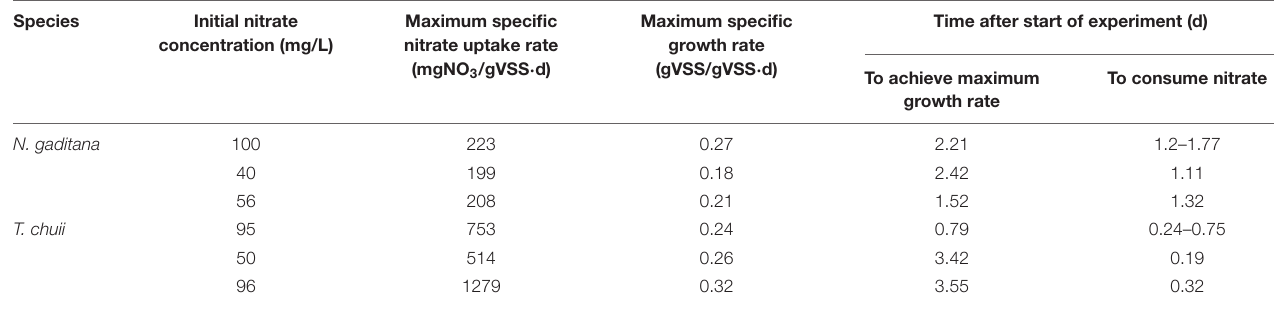
TABLE 4 | Summary of results obtained from the nitrate uptake experiments by N. gaditana and T. chuii .